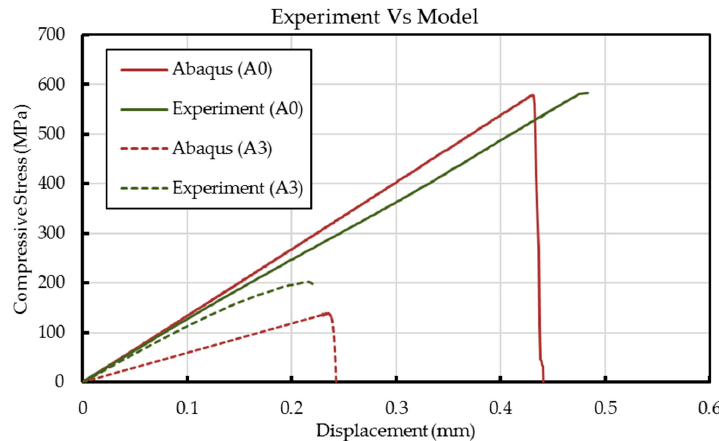
Figure 10. Experimental data and model predictions of compressive stress vs. displacement behavior of A0 and A3 samples.